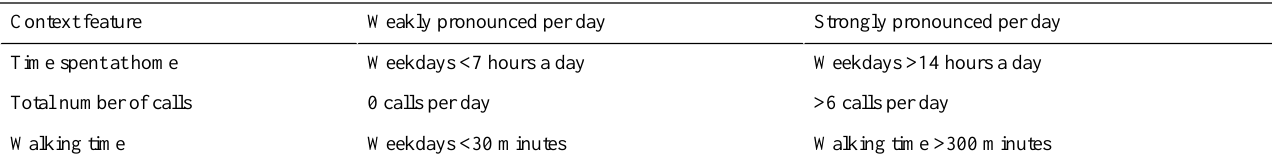
Table 1. Assumptions about people with